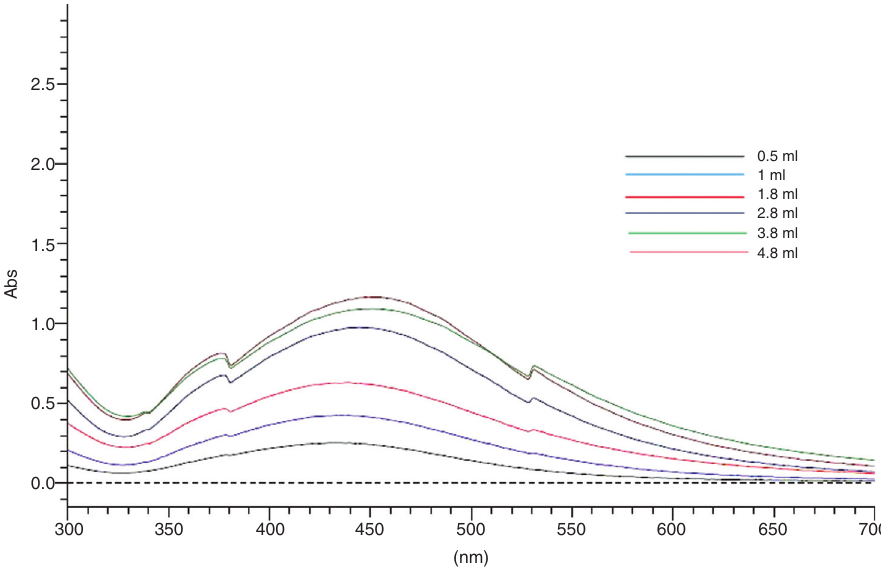
Figure 4: Effect of fruit extract quantity on AgNPs synthesis.